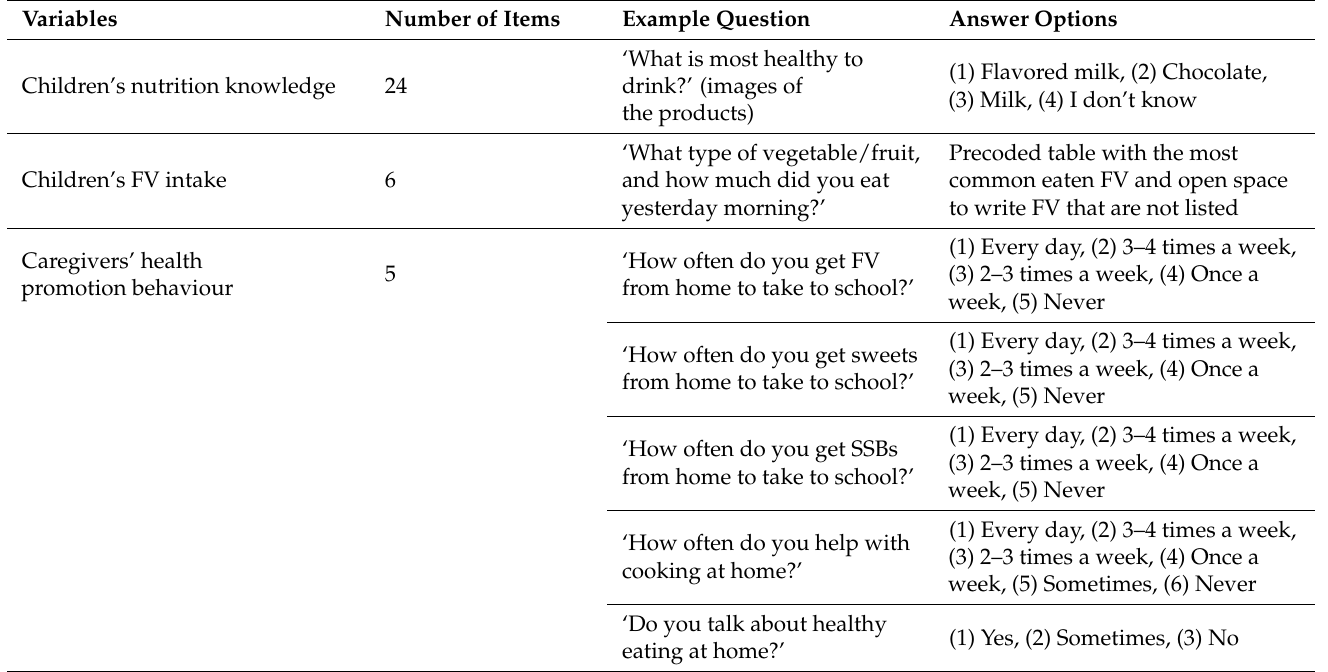
Table 1. Variables, number of questions and example of questions and answer options.